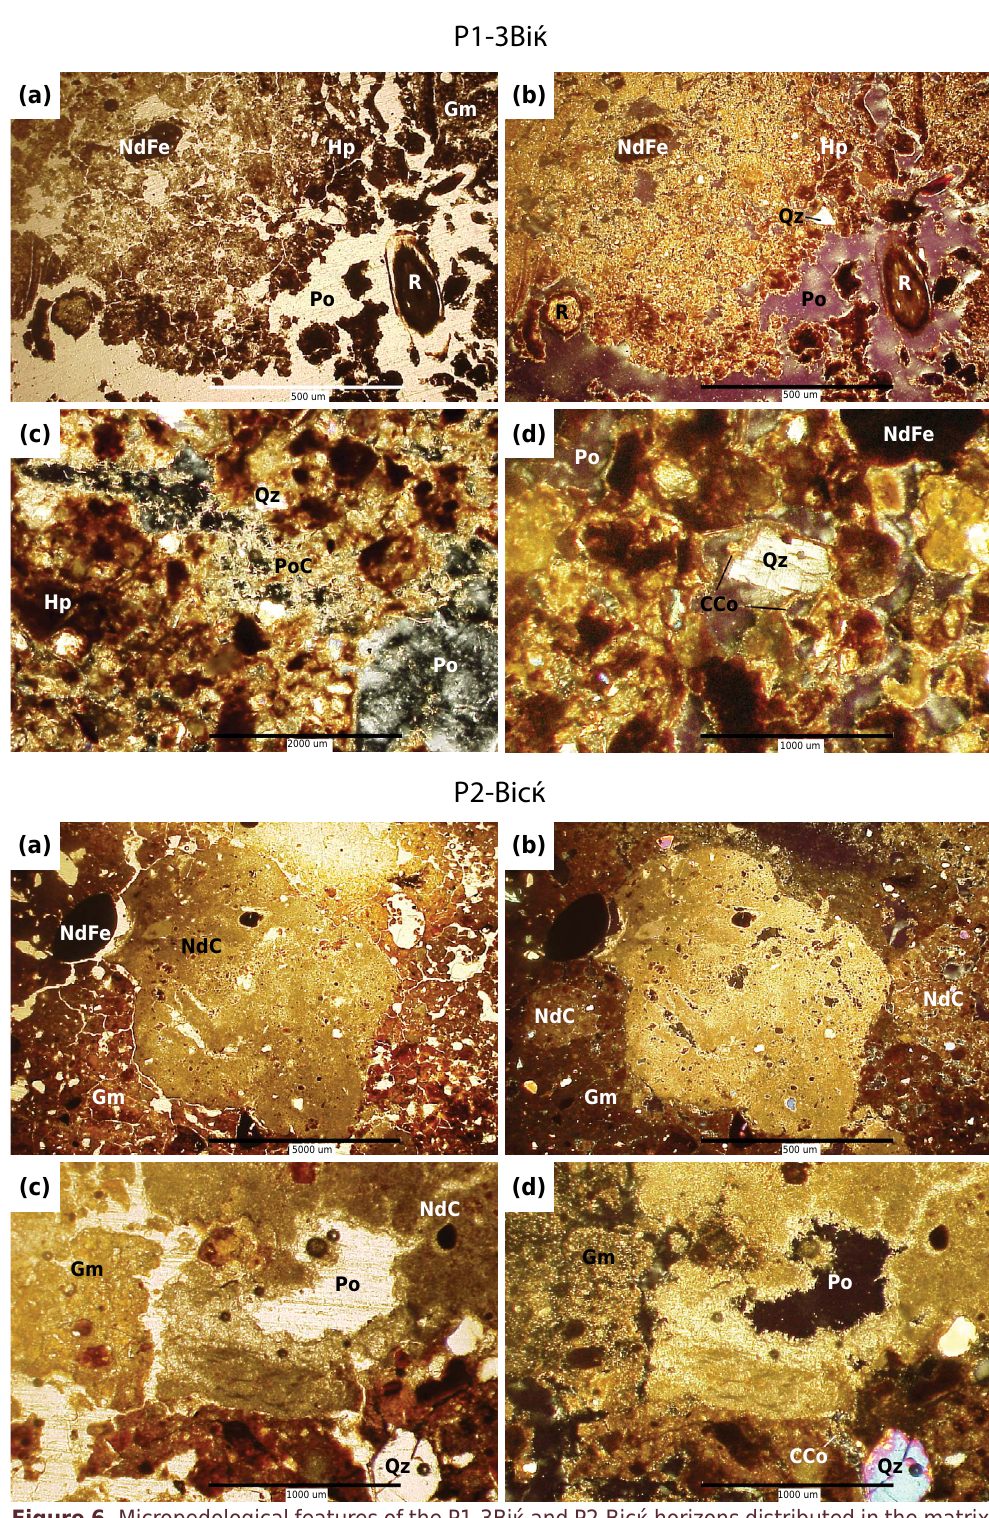
Figure 6. Micropedological features of the P1-3Biќ and P2-Bicќ horizons distributed in the matrix and observed under natural (a) and polarized light (b, c, d). Quartz (Qz), Pores (Po), Iron nodules (NdFe), Iron hypo-coating (Hp), Traces of root tissues (R), Calcite nodules (NdC), matrix with birefringent crystals (Gm), Calcite coating (CCo), Calcite-filled pore